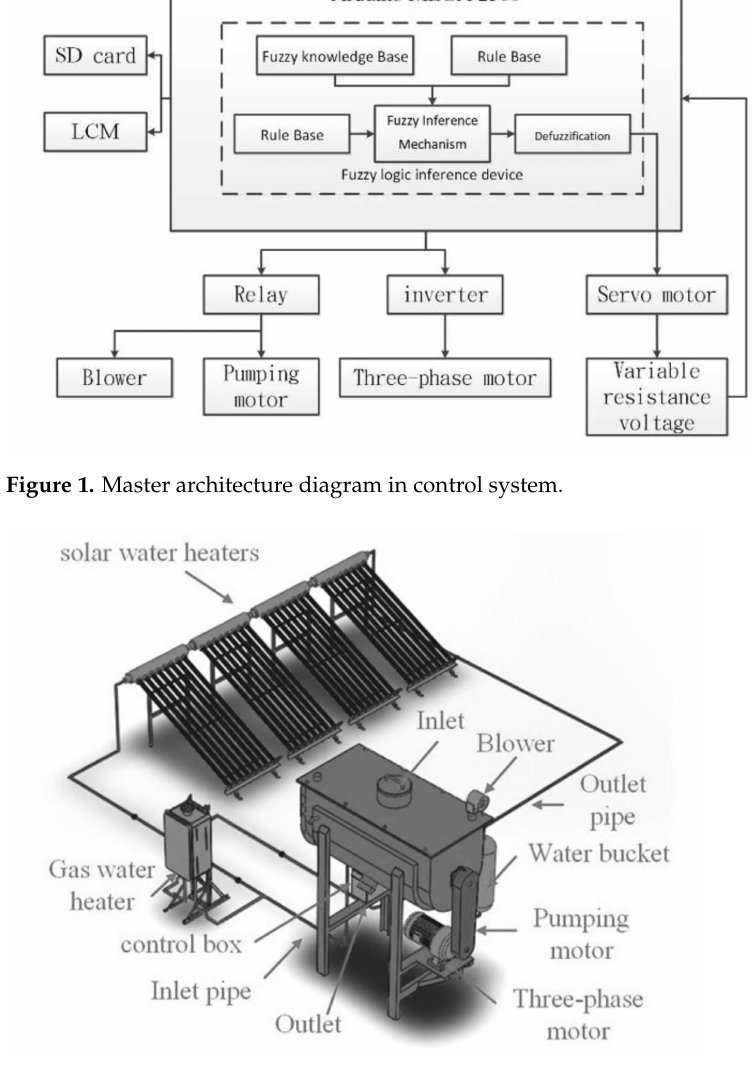
Figure 2. Outfit of intelligent solar chicken manure fermentation